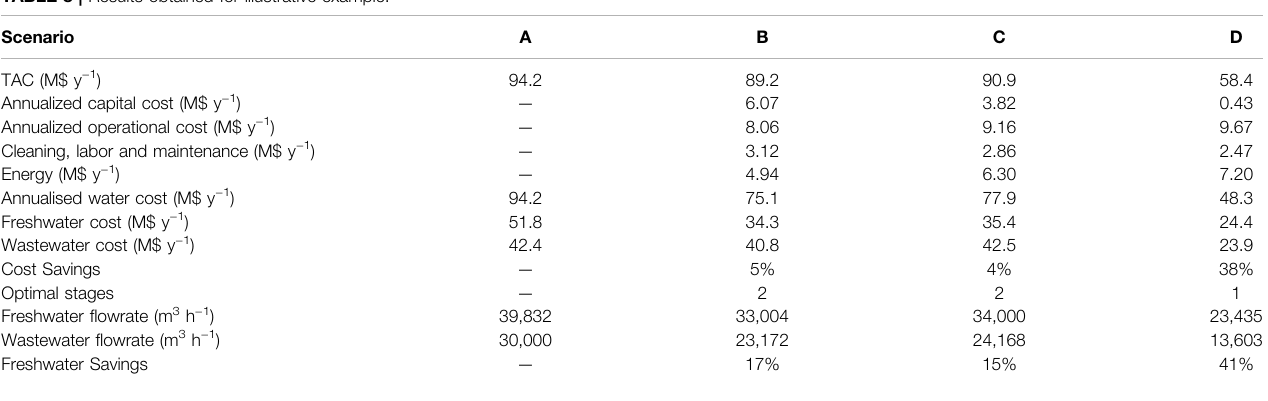
TABLE 8 | Results obtained for illustrative example.